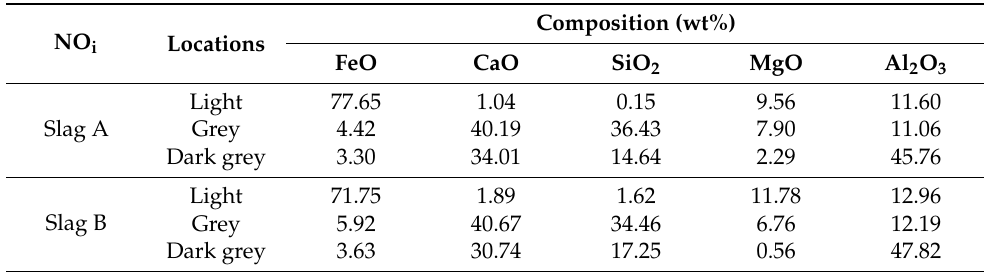
Table 2. EDS composition at different